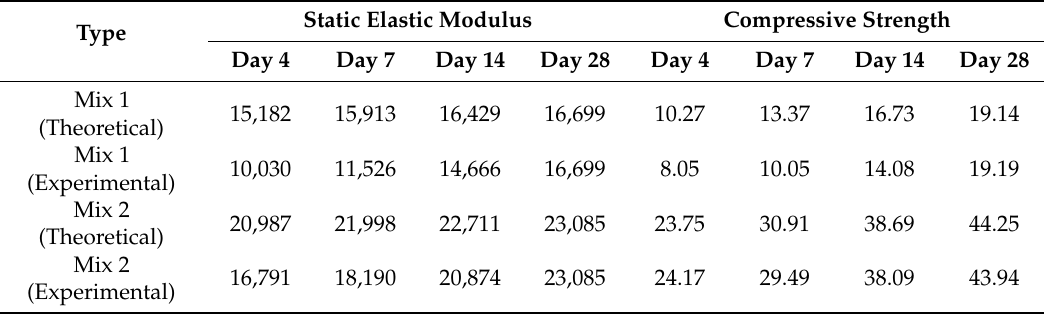
Table 3. Comparison of experimental (mean) and theoretical values for Ec and